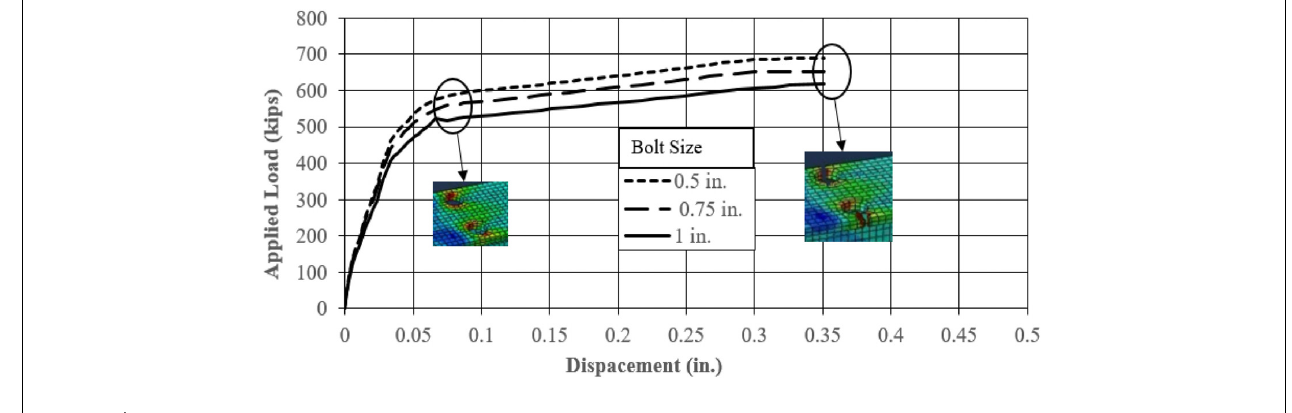
FIGURE 3 | FEA results for the W16 × 45 section with different bolt size.